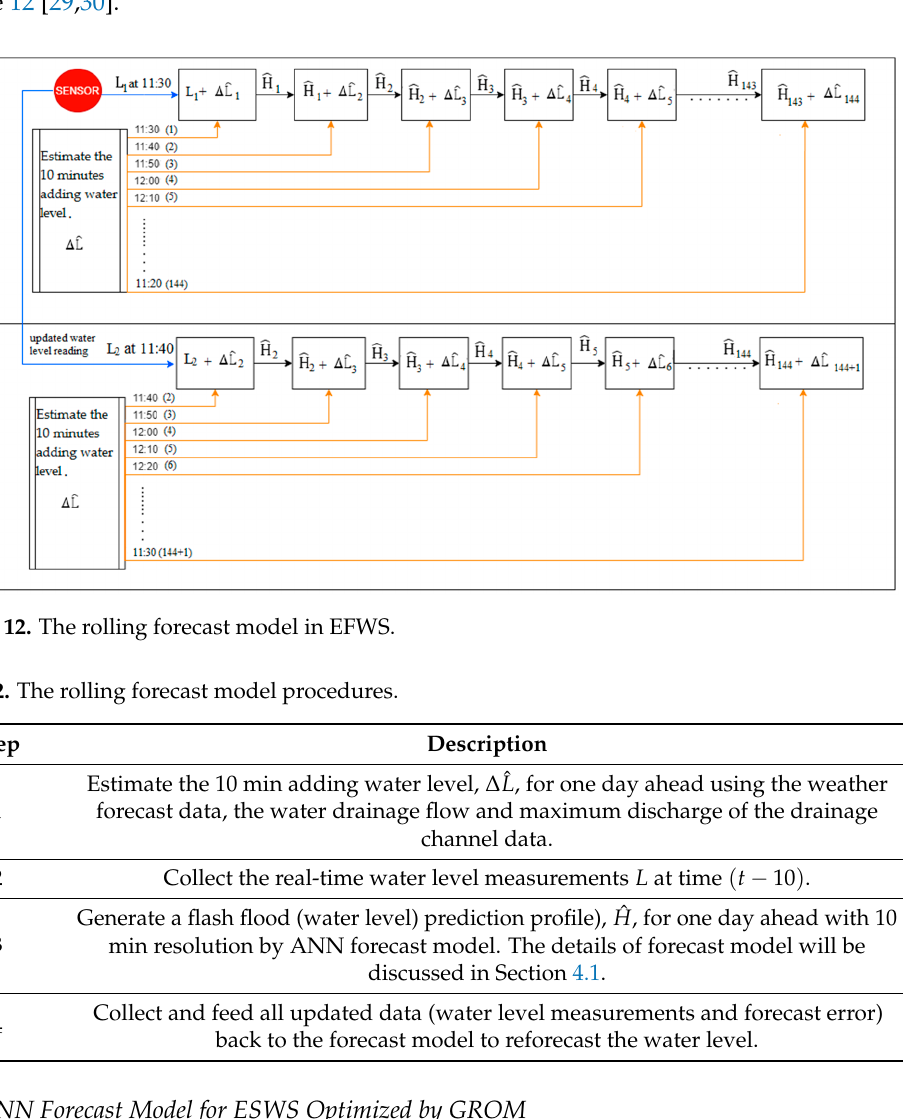
Table 2. The rolling forecast model procedures.